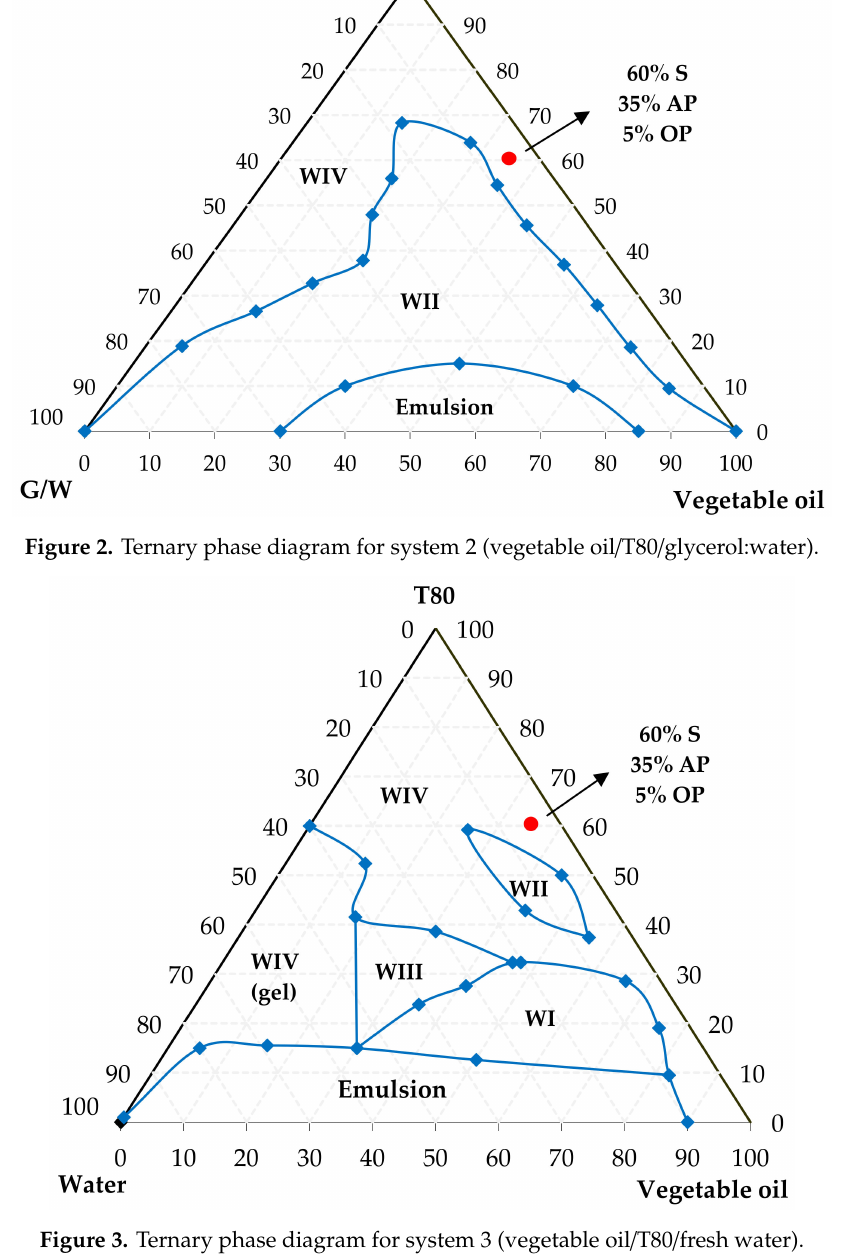
Figure 3. Ternary phase diagram for system 3 (vegetable oil / T80 / fresh